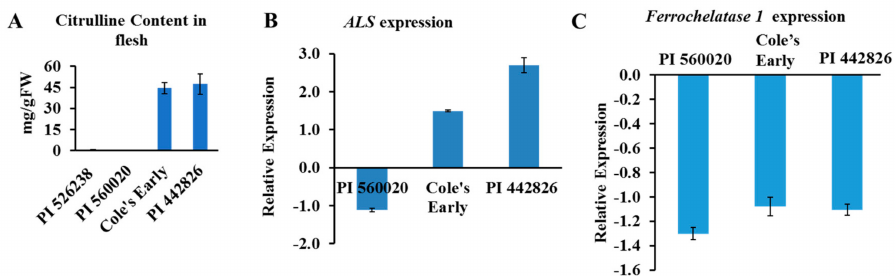
Figure 6. ( A ) Citrulline content and expression of candidate genes in flesh of selected watermelon accessions. Data are means ± SD ( n = 3). ( B ) Expression of acetolactate synthase ( ALS ) and ( C ) Ferrochelatase 1 genes in flesh. PI 526238 accession, with low citrulline content, was used as a calibrator for relative expression in ( A ). Gene expression was normalized to that of Actin 8 . Data are means ± SD ( n = 3).